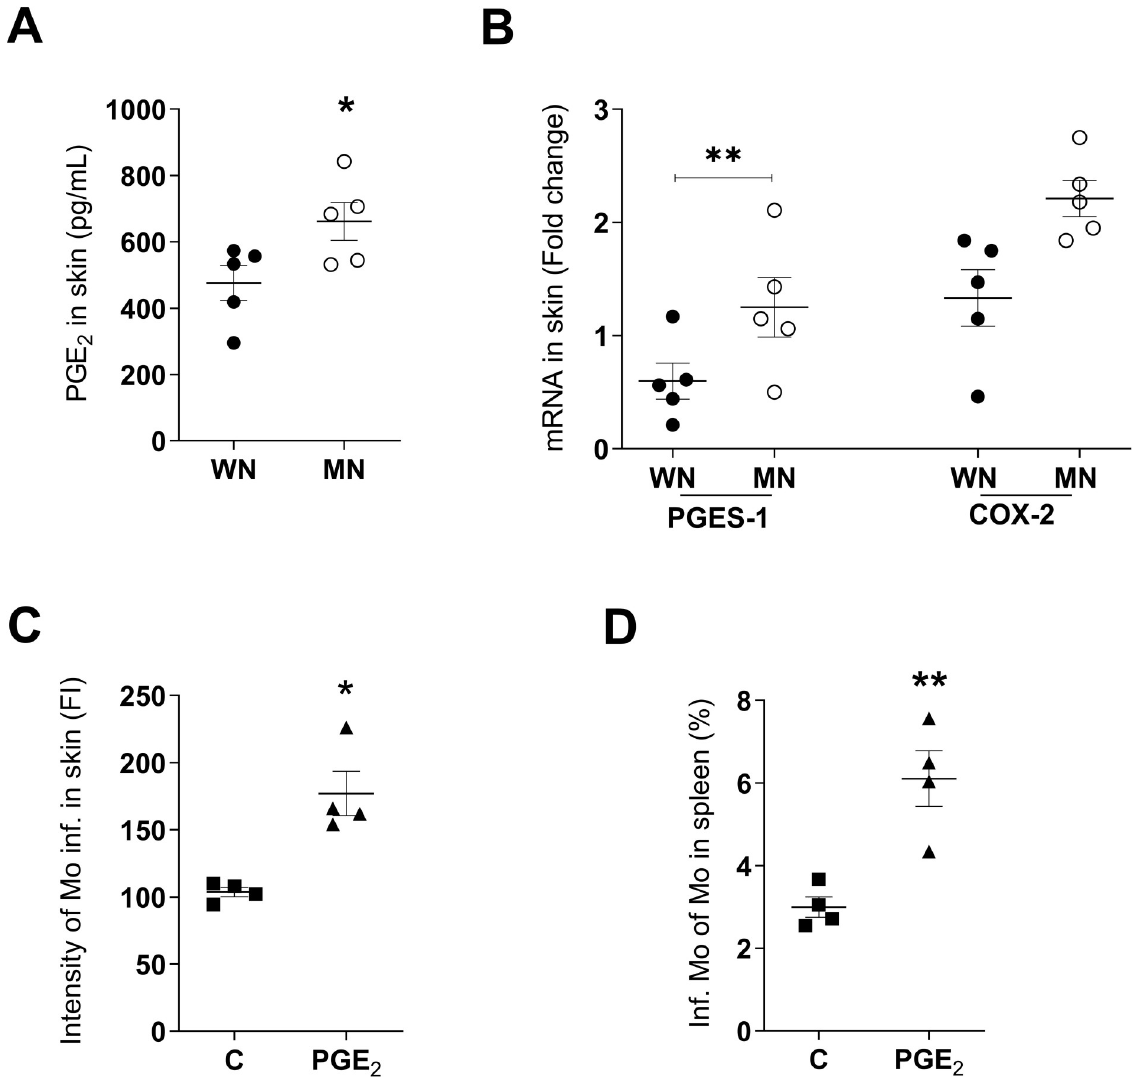
Fig 4. PGE 2 enhances L . donovani infection of inflammatory monocytes and their trafficking from skin to spleen. A . Prostaglandin E 2 (PGE 2 ) production in skin of control (well-nourished; WN) or malnourished (MN) mice at 24h after L . donovani infection; determined by competitive ELISA. � p = 0.04 (Unpaired t-test). B . PGE 2 synthase-1 (PGES-1) and cyclooxygenase-2 (COX-2) mRNA expression at site of L . donovani skin infection in WN and MN mice at 24h post-infection; determined by qPCR. � p = 0.01 (Unpaired t-test). C . Intensity of infection (fluorescence intensity from PKH-26 labeled parasites) of skin monocytes from normal (WN) mice infected intradermally with L . donovani and treated with DMSO (control; C) or PGE 2 , (10 ng per dermal infection site in DMSO). Evaluated at 48h p.i. by flow cytometry. � p = 0.02 (Mann-Whitney test). D. Percent of infected monocytes in spleen of normal mice infected intradermally with L . donovani and treated intradermally with DMSO control (C) or 10 ng PGE 2 at the time of ID infection. Evaluated at 48h p.i. by flow cytometry. �� p = 0.004 (Unpaired t-test). N = 4–5 mice per group. malnourished mice treated with a PGES-1 inhibitor ( Fig 6A ). Since PGE treatment of normal 2 mice increased CCR7 expression on monocytes (Fig 5B and 5C) , we used the PGES-1 inhibi- tor to evaluate the link between PGE and CCR7 expression in monocytes, and monocyte- 2 mediated parasite dissemination. In vivo treatment of MN mice with the PGES-1 inhibitor sig- nificantly reduced (to control levels) the trafficking of infected monocytes from skin to spleen ( Fig 6B ). We found a reduced proportion of infected inflammatory monocytes that expressed